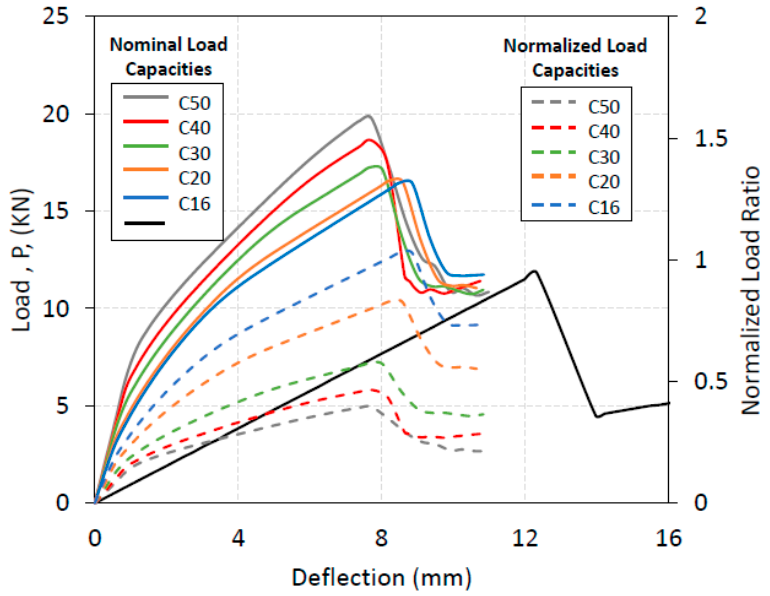
Figure 9. Nominal and normalized load deflection curves of hybrid beams with varied